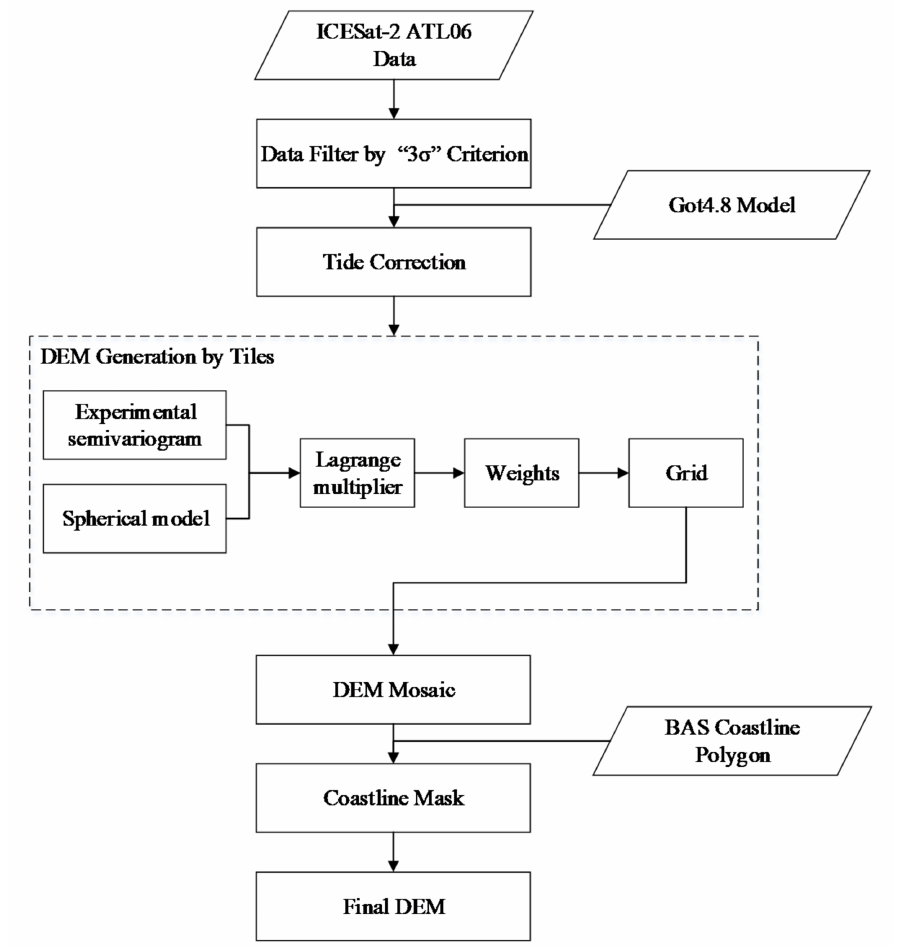
Figure 3. Flow diagram of final DEM